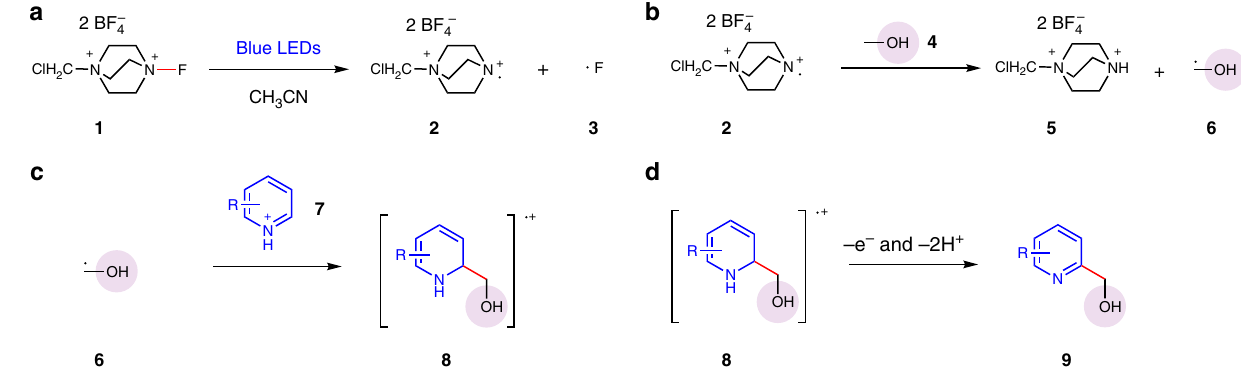
Fig. 3 The designed reaction pathways. a The N – F activation of select fl uor under blue LEDs irradiation. b The hydrogen-atom transfer (HAT) between generated N radical cation with alcohols to yield hydroxyalkyl radical. c The nucleophilic addition of hydroxyalkyl radical to electron-de fi cient heteroarenes. d The oxidative aromatization of the radical adducts to the fi nal product